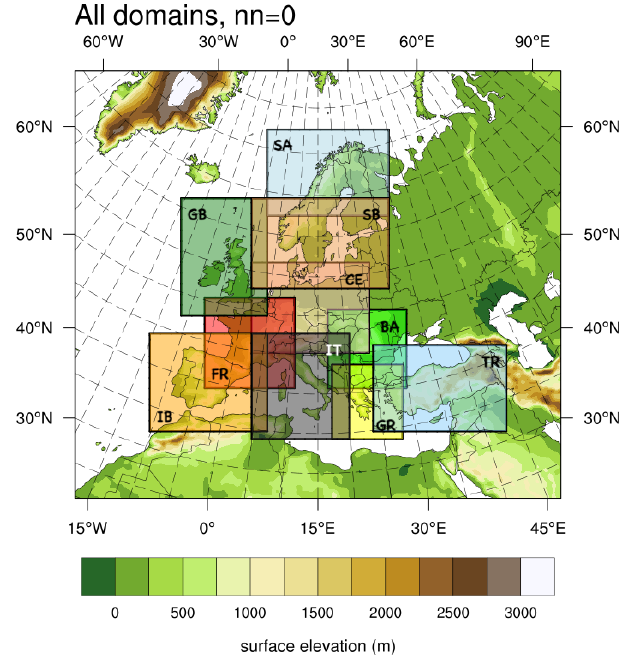
Figure 1. The location of 10 WRF model domains (D3) used in the NEWA production run, excluding a 30 grid point buffer around each domain. The background map corresponds to D1, which is the same for all simulations. D2 domains are not shown Hasager et al. (reproduced from